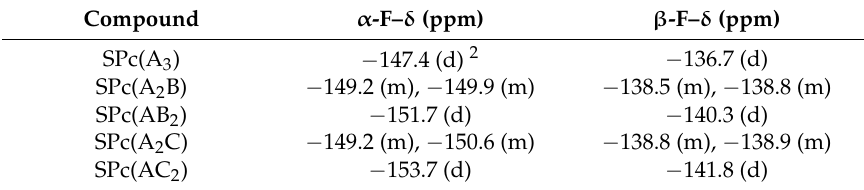
Table 1. 19 F NMR data for fluorinated SPcs 1